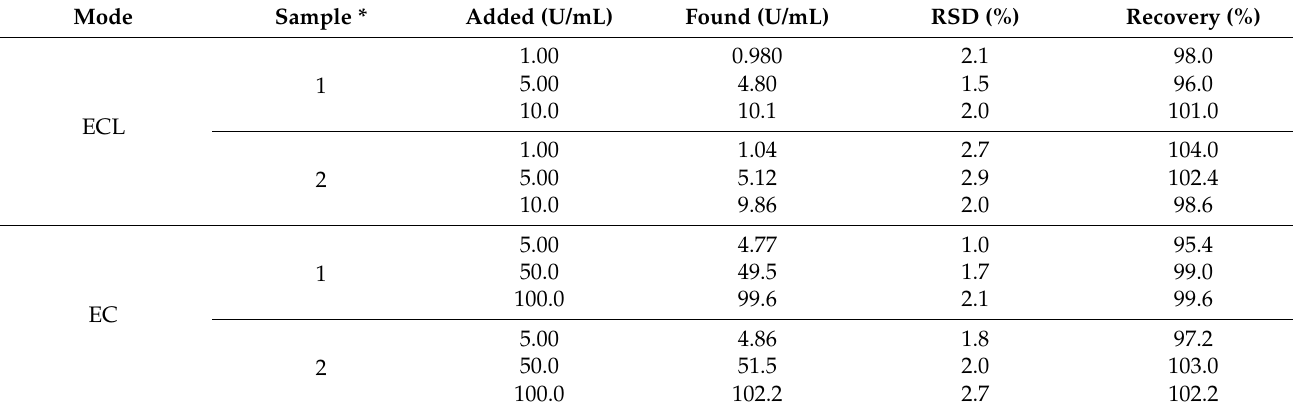
Table 2. Detection of CA 15-3 in human